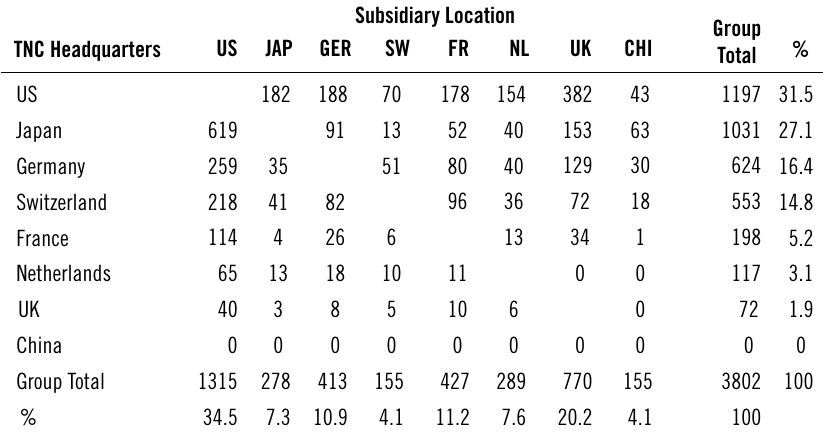
Table 6 – Ownership and Location of Foreign Subsidiaries of 100 Largest Table 7 – Ownership and Location of Foreign Subsidiaries of 100